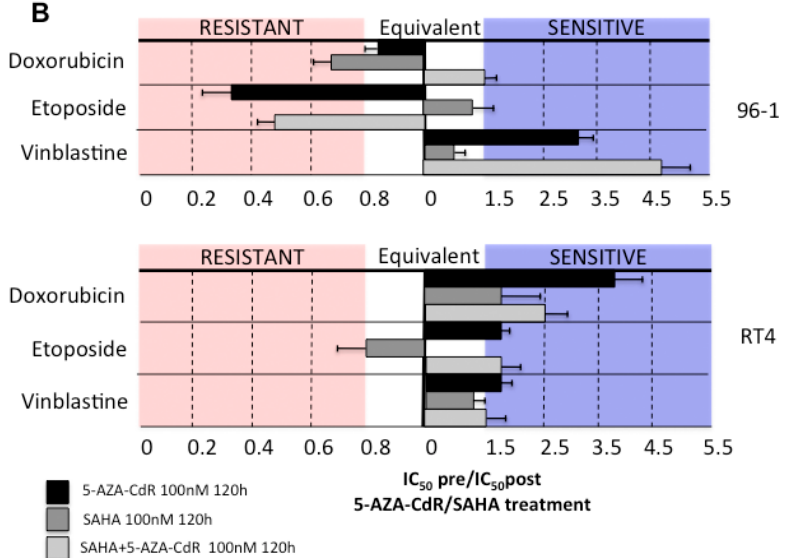
Figure 4. Chemoresistant bladder cancer cell lines can be sensitized to chemotherapeutics by epigenetic modifiers. ( A ) Treatment with the epigenetic inhibitors decitabine and vorinostat significantly lowers IC 50 values for cisplatin in the resistant bladder cancer cell lines 96-1, 97-1, RT4 and SW1710. Cell lines were treated with 100 nM decitabine, 100 nM vorinostat, 100 nM decitabine + vorinostat or vehicle (DMSO) for 120 h, incubated with cisplatin for 48 h and then cisplatin IC 50 values were calculated. The graph shows fold compound reduction to vehicle. Experiments were run in triplicates to obtain mean IC 50 values; ( B ) Decitabine and vorinostat induce sensitization for doxorubicin, etoposide and vinblastine in the cisplatin resistant bladder cancer cell lines 96-1 (top) and RT4 (bottom). Cell lines were treated with 100 nM decitabine, 100 nM vorinostat, 100 nM decitabine + vorinostat or vehicle for 120 h, incubated with cisplatin for 48 h and then cisplatin IC 50 values were calculated. The graph shows IC 50(vehicle) /IC 50(post-AZA) . Experiments were run in triplicates to obtain mean IC 50 values. 5-AZA-CdR: decitabine; SAHA: vorinostat.